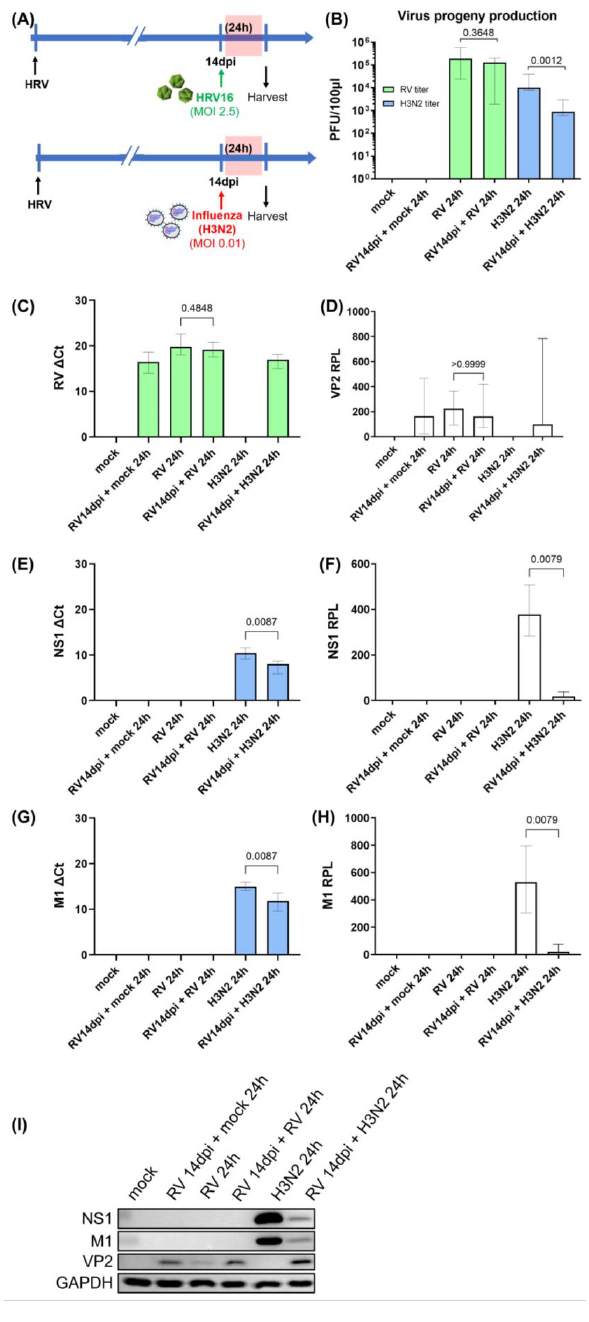
Figure 1. Reduction in virus progeny production and expression of IAV NS1 and M1 proteins of secondary H3N2 infection, but not HRV VP2 of HRV-A16 re-infection in hNECs (following primary prolonged HRV infection). ( A ) Timeline of prolonged primary HRV infection and subsequent sec- ondary H3N2 infection or HRV-A16 re-infection. ( B ) Infectious virus progeny was quantified (PFU per 100 µ L) using plaque assay ( n = 7). There were no significant changes in ( C ) HRV RNA or ( D ) VP2 protein of HRV re-infection as compared to single HRV infection and controls. ( E – H ) However, IAV RNAs and relative protein levels (RPL) of NS1 and M1 of secondary H3N2 infection were significantly reduced ( n = 5). The relevant band intensities were measured using ImageJ software. The corresponding p -values are shown. The p -values were calculated by comparison with single infection of the respective virus using the non-parametric Mann–Whitney U-test. The data are represented as medians with interquartile values. ( I ) Representative Western blot images are